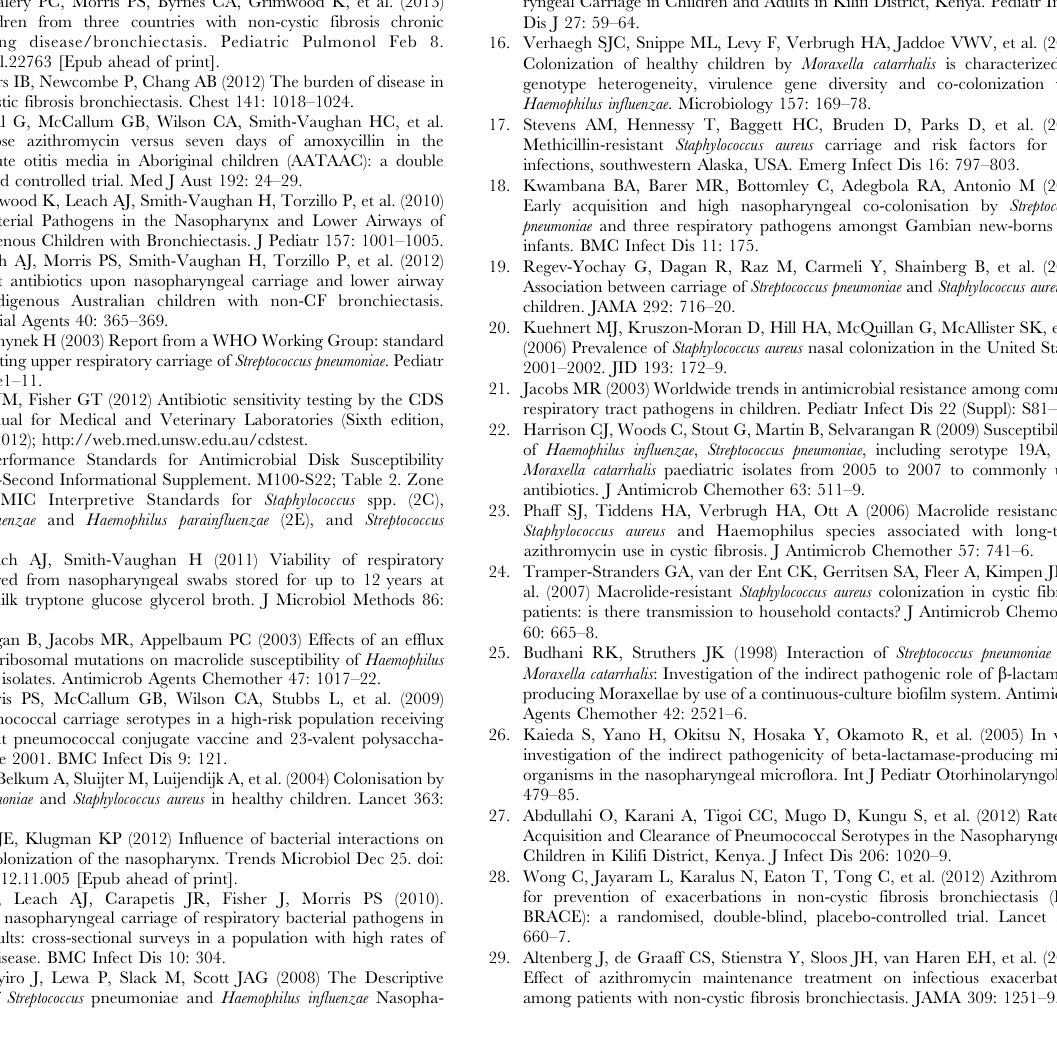
Table S2 Antibiotic resistance (proportion of carriers) in respiratory bacteria from Australian children, grouped by azithromycin exposure 1 , at baseline and end of study. 1 Australian children were grouped by proportion of study visits with azithromycin use , 2-weeks before swab collection at: Azi-None = no study visits; Azi-Infreq(uent) = 1– 50% of study visits; Azi-Freq(uent) =51–100% of study visits.